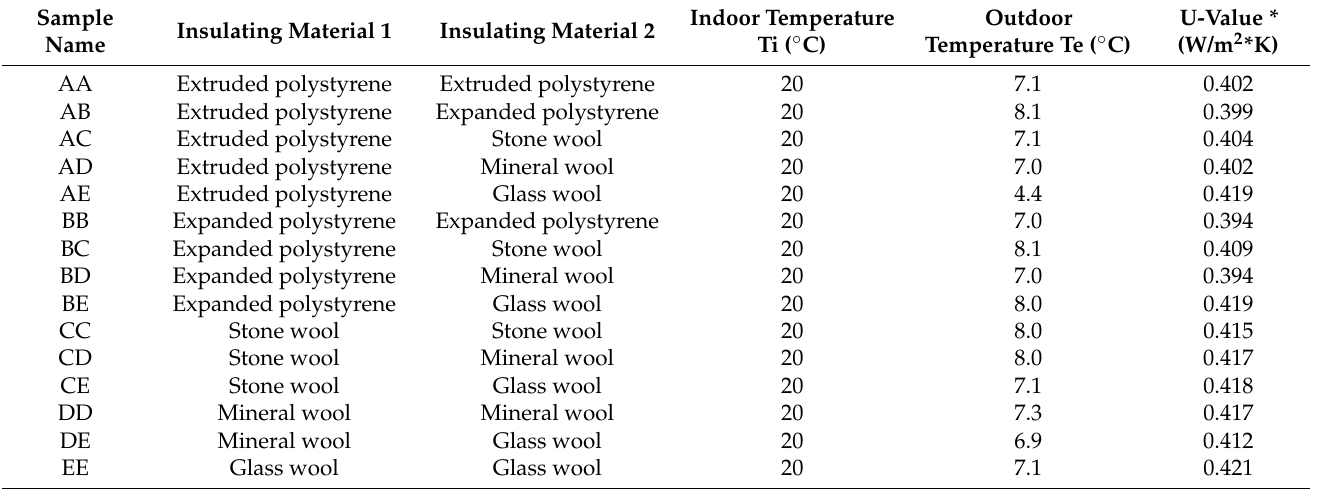
Table 4. Laboratory readings of the thermal transmittance, the indoor and outdoor temperatures of the timber wall with the combinations of the insulating